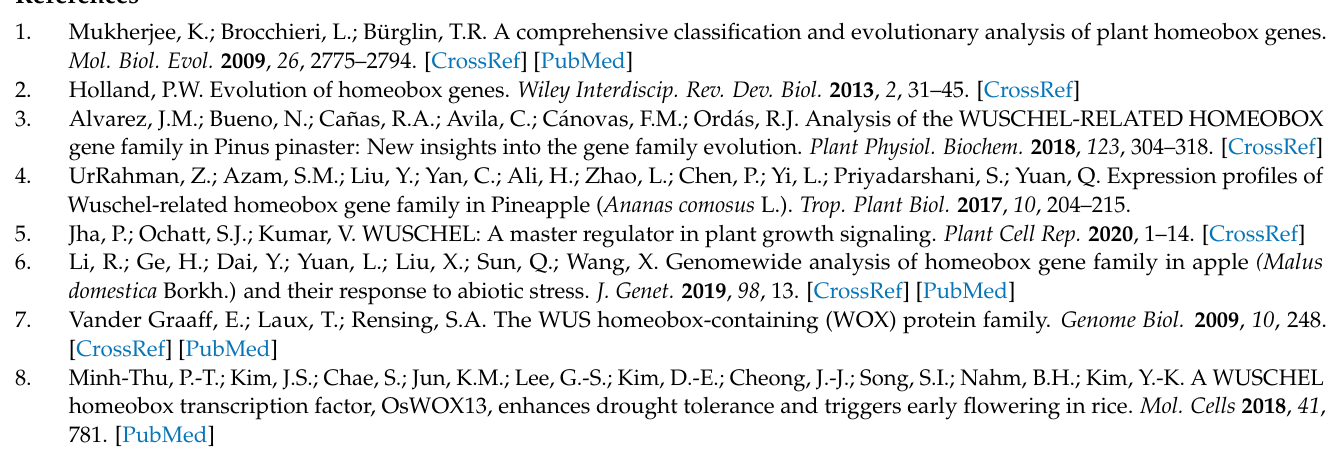
Figure S4: (A) Phenotypic analysis of some transgenic lines from CsWUS . (B) Relative expression of endogenous WUS homolog ( NtWUS ) in transgenic CsWUS -OE tobacco lines. NtActin was worked